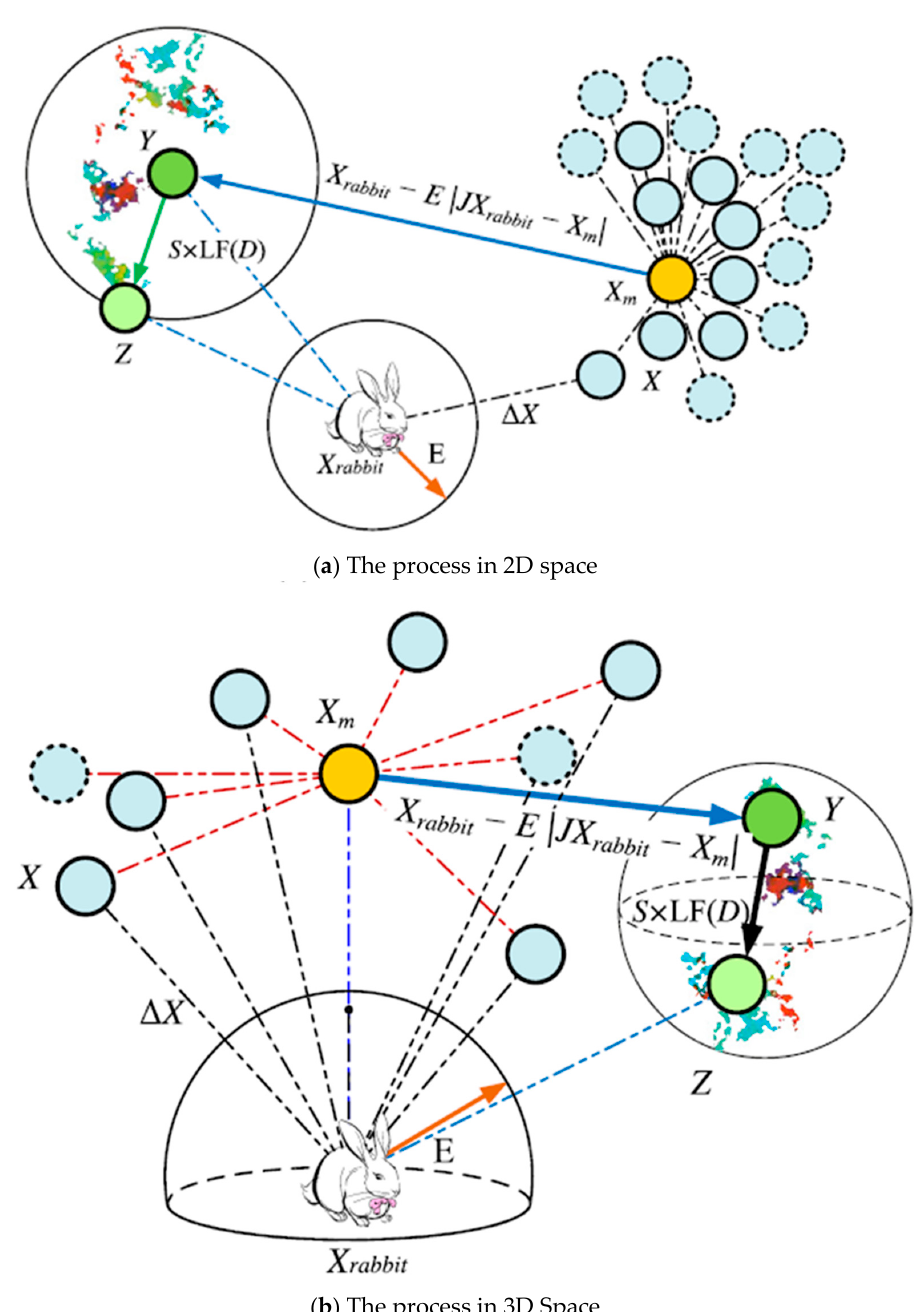
Figure 5. The position vectors for hard siege mode with progressive rapid dives in 2D and 3D space. [50].